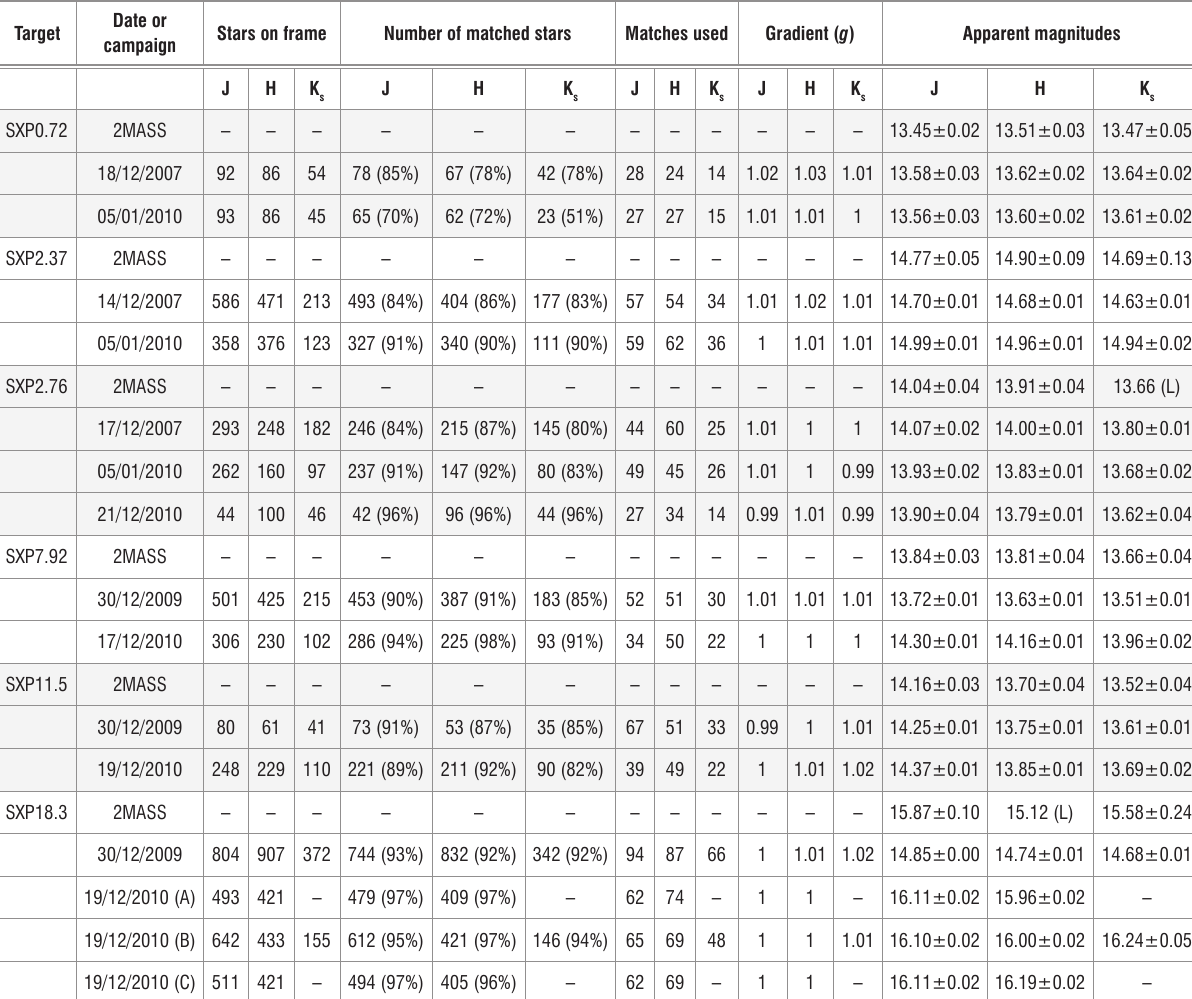
Auto-calibration results for six Be/X-ray binaries in the Small Magellanic